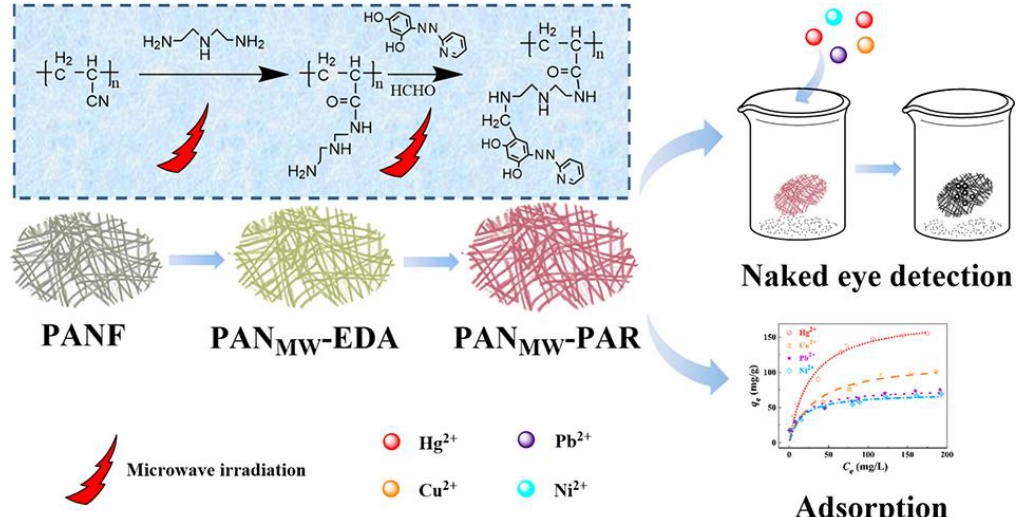
Figure 11. Scheme of PAN MW -PAR synthesis and sorption isotherms for Cu(II), Hg(II), Ni(II), and Pb(II). [87].